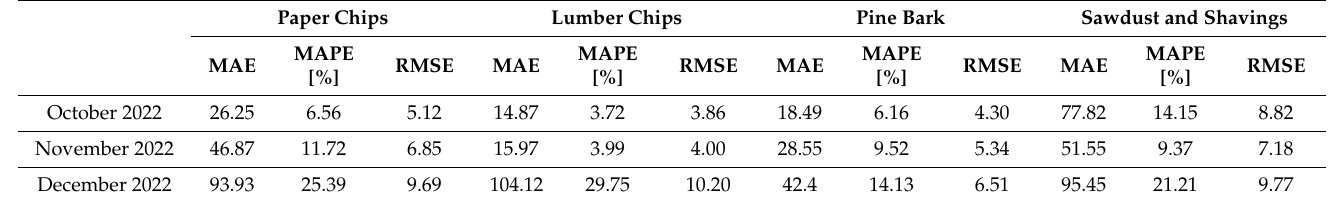
Table 9. Summary of MAE, MAPE and RMSE for the prediction using